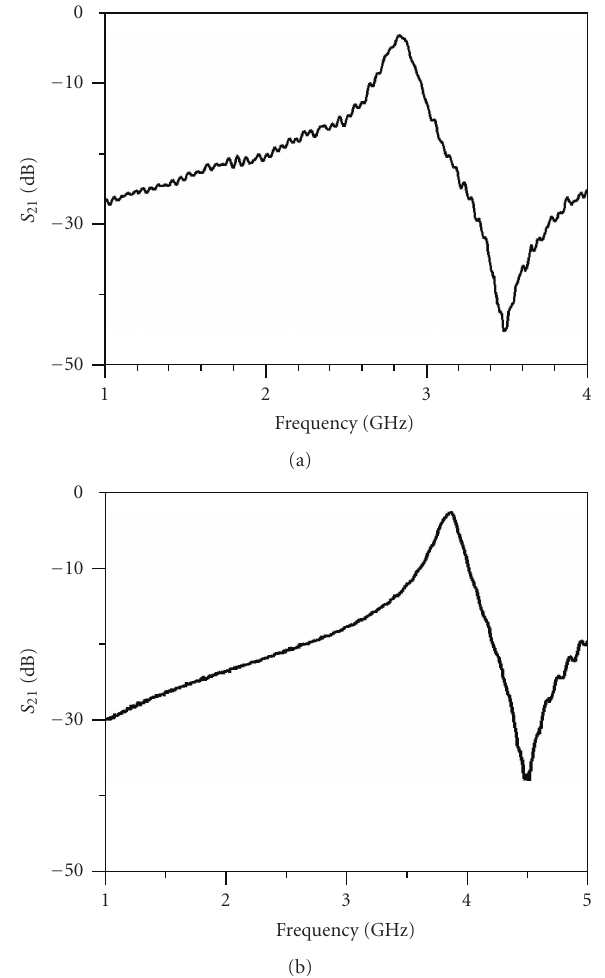
Figure 21: S 21 (dB) for (a) capacitive (folded resonator) and (b) W -shape